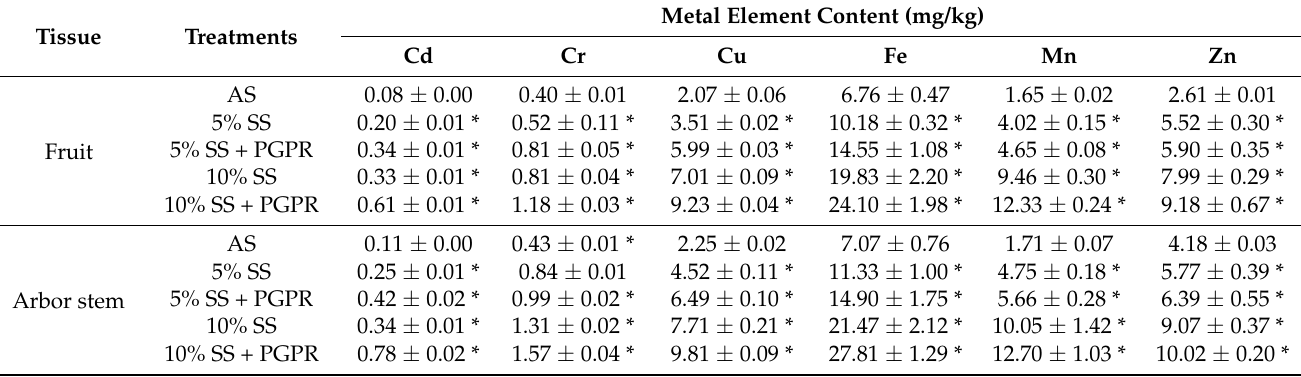
Table 5. Contents of metal elements (mean ± standard deviation, n = 3) accumulated by different plant tissues of Ridge gourd ( L. acutangula ) grown under different sewage sludge (SS) and plant growth-promoting rhizobia (PGPR)